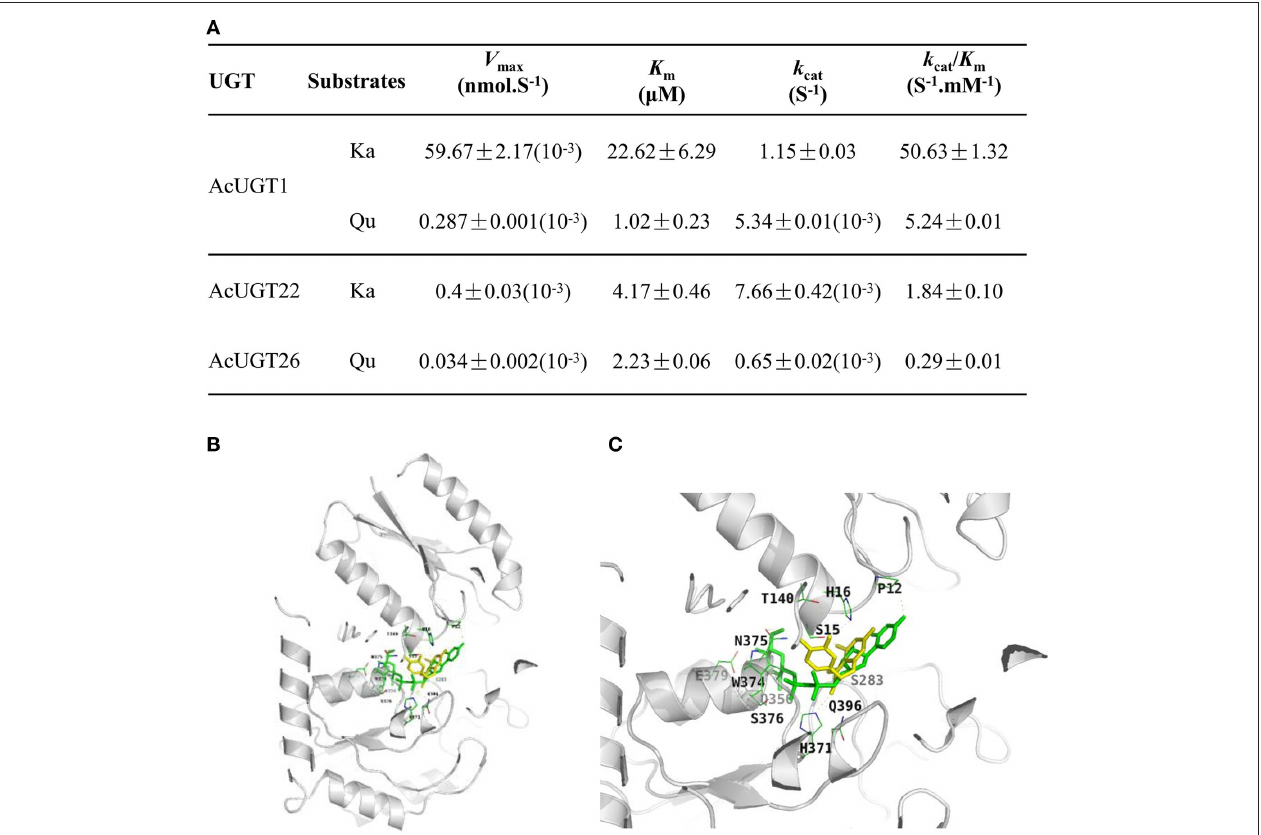
FIGURE 5 | Characterization of AcUGTs. (A) Kinetic characteristics of three AcUGTs. (B) A ribbon diagram of UDPG and quercetin with AcUGT1. (C) An enlarged ribbon diagram of the active docking domain. UDPG is indicated in green and quercetin in